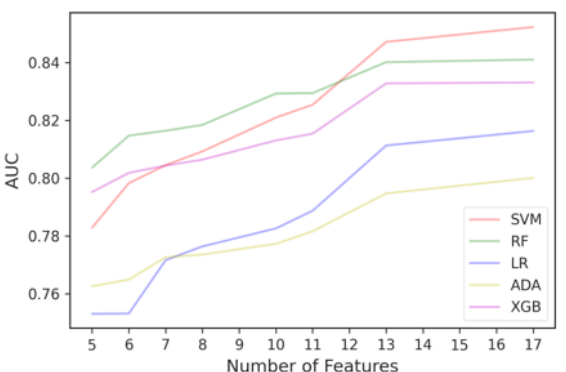
Figure 11. Classification performance curve from adding important features selected by MRMR batch-by-batch.